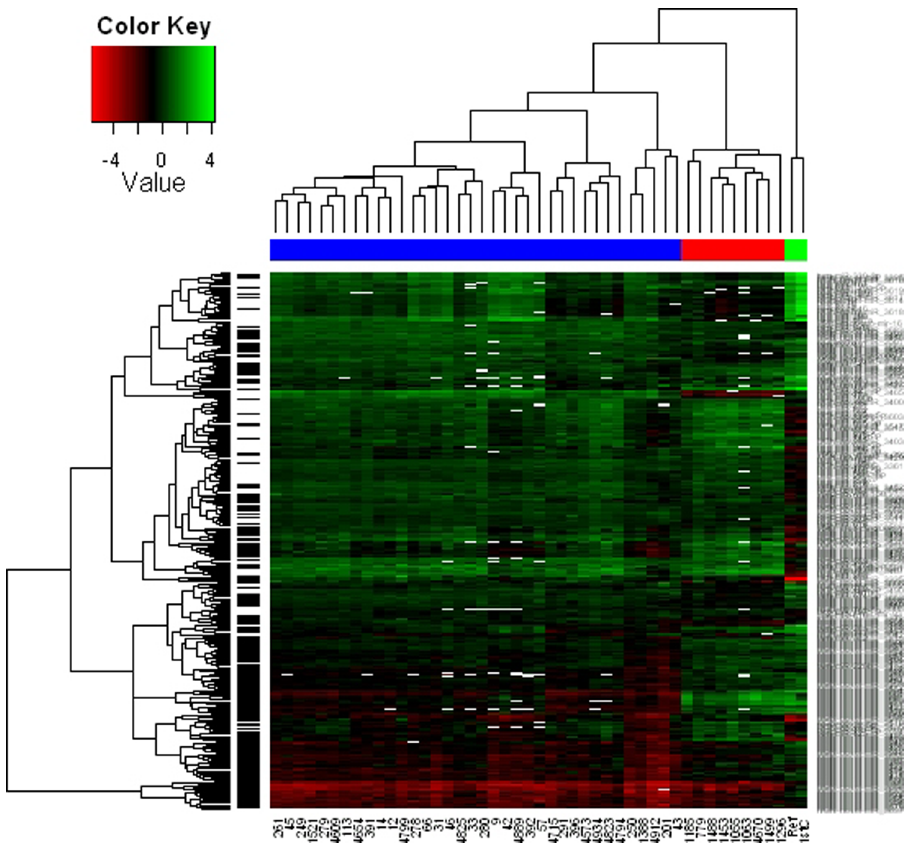
Figure 1. Hierarchical clustering of all significant miRNAs. Hierarchical clustering was performed on 312 differentially expressed miRNAs using a correlation metric. Included miRNAs have significantly different expression levels in at least one pair-wise comparison between the general sample types fetal, young and adult. The sample types are indicated in the colored bar (blue-fetal, red-young, green-adult).